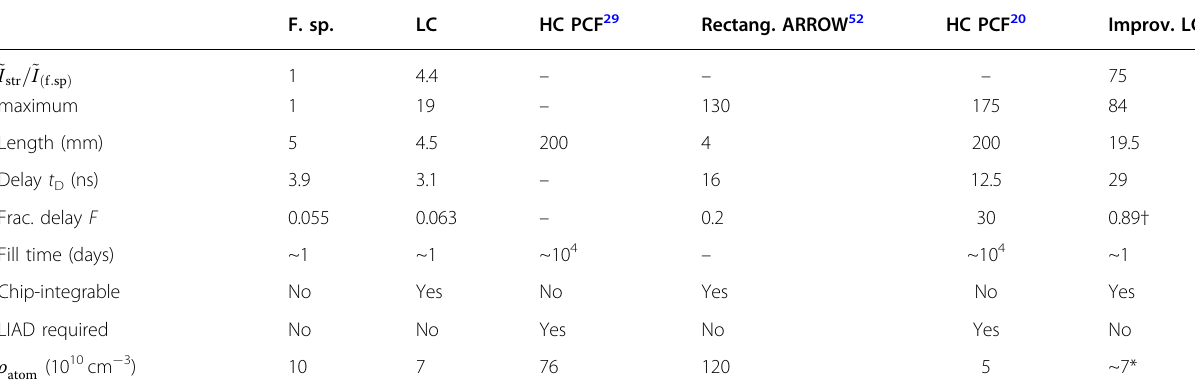
Table 1 Comparative overview on light delay in different types of waveguides